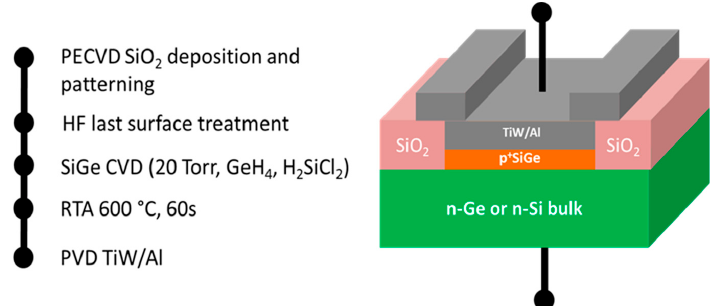
Figure 1. The p + / n diode fabrication flow is shown in the left. The resulting device is depicted on the right. Each device is accessed from the top via a TiW / Al metal stack and the bottom of the bulk substrate via the measurement unit’s